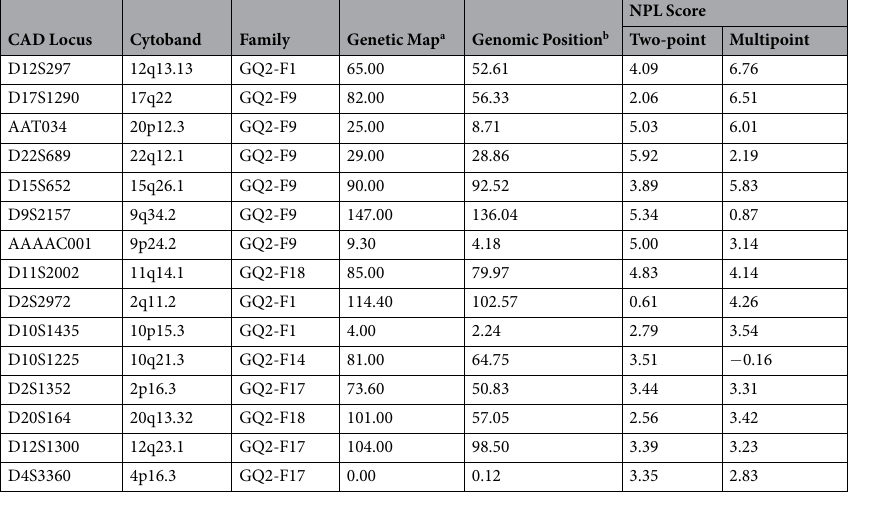
Table 4. New Genetic Loci for CAD Identified by GWLS in Individual GeneQuest II Families. a The genetic map position was based on Marshfield Medical Genetic marker set 11. b Physical genomic position was retrieved from the UCSC database with human build